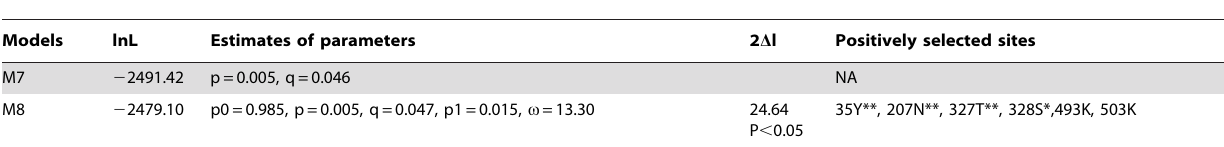
Table 6. Site-specific tests for positive selection on HPV-16 L1.